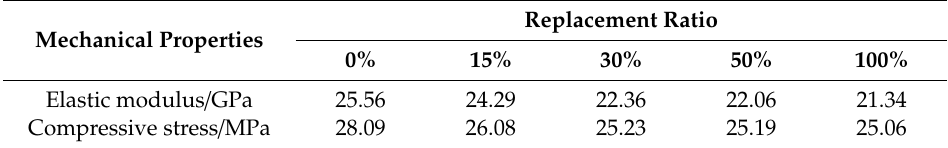
Table 3. E ff ect of substitution on the mechanical properties of